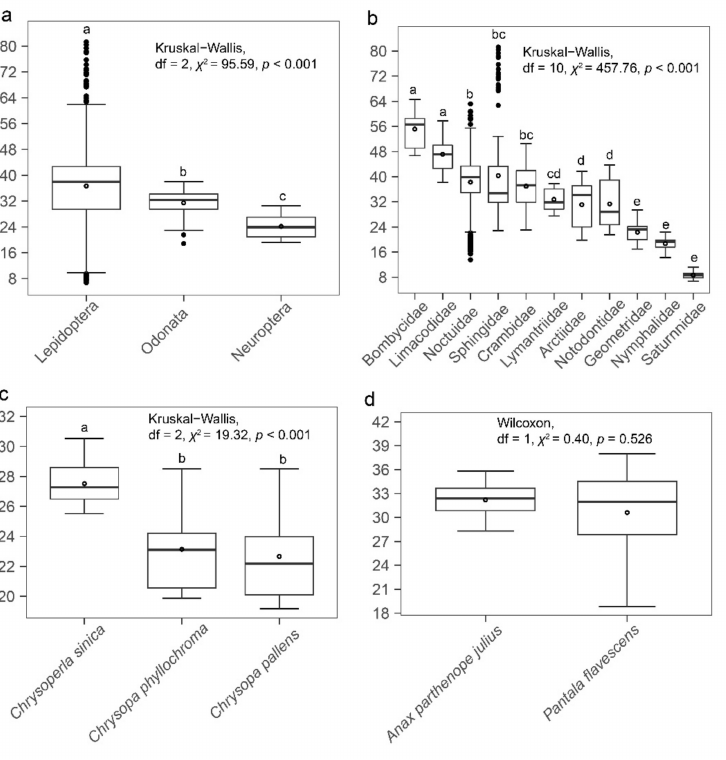
Figure 2. Differences in wingbeat frequency among ( a ) orders; ( b ) lepidopteran families, adapted from [21]; ( c ) neuropteran species; and ( d ) odonatan species. From bottom to top, each box-and- whisker plot represents the minimum, lower quartile, median, upper quartile, and the maximum, and the empty circle represented the mean. Bars with the same letter indicate no differences in WBF.